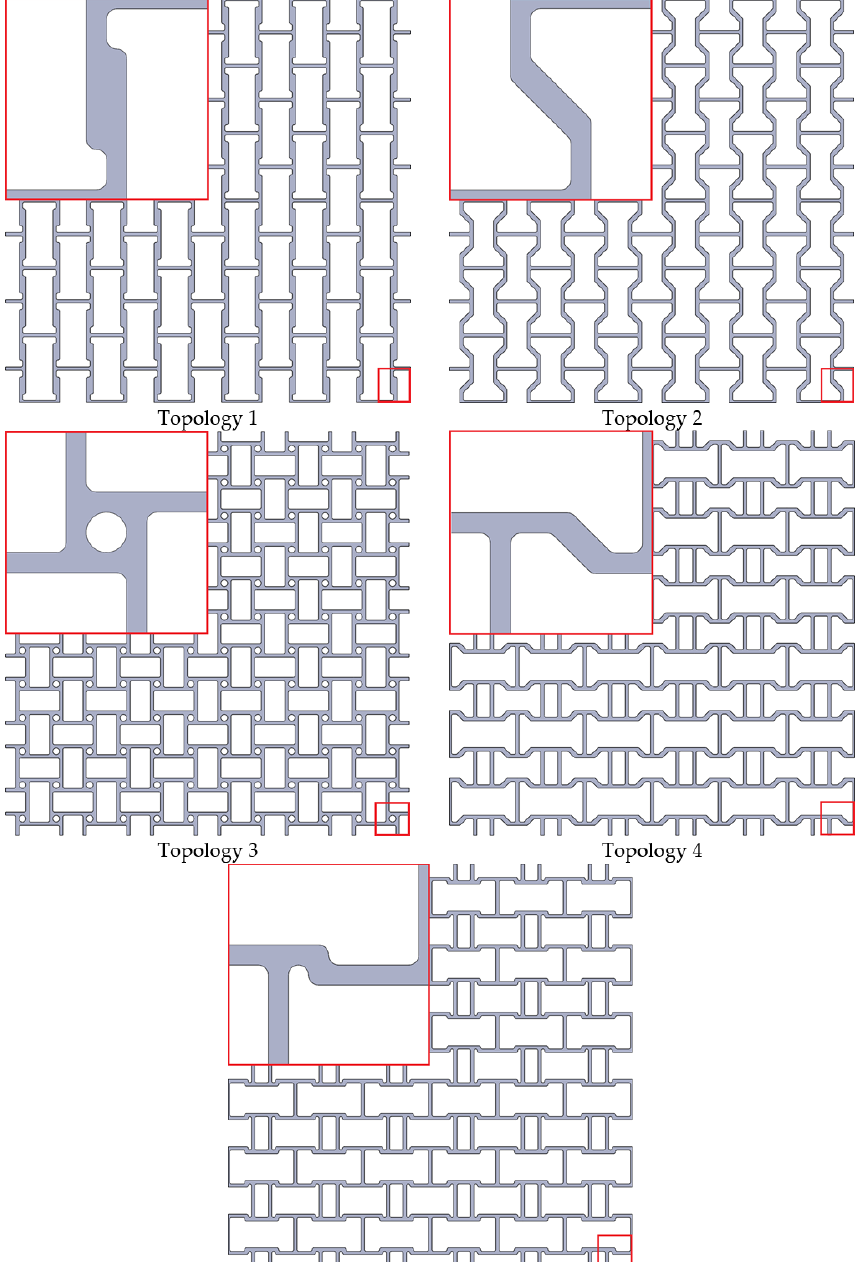
Figure 3. Selected quarter unit cell topologies and resulting auxetic structures.